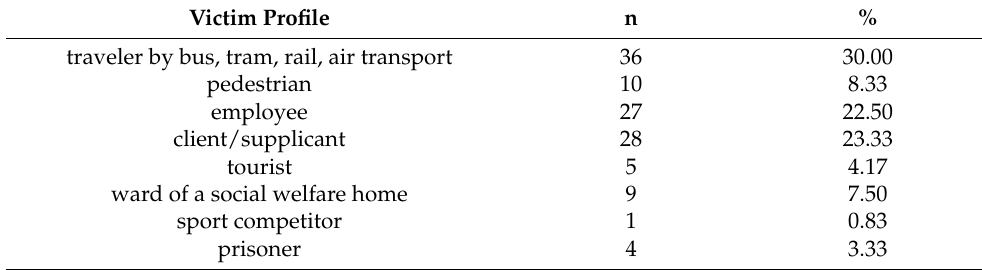
Table 2. Profile of the person on whom the AED has been used (n =